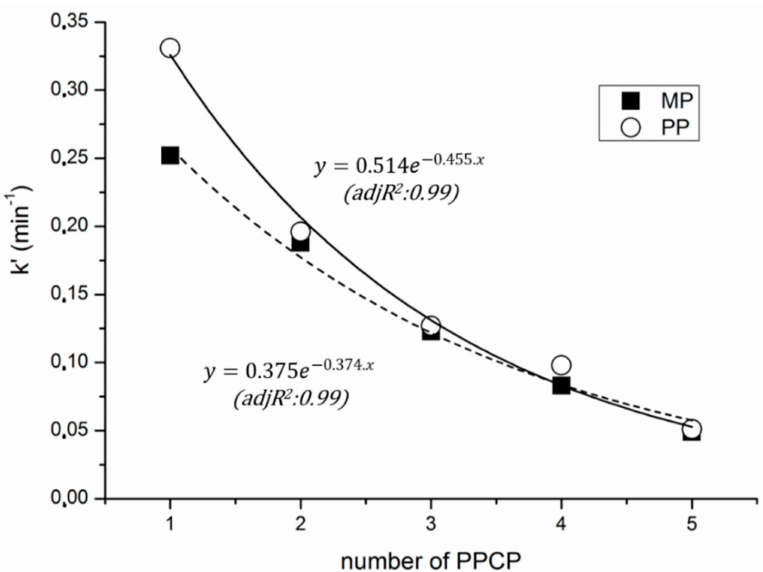
Figure 5. Variation of pseudo-first order kinetic constant rate for MP and PP with the number of contaminants present in the initial